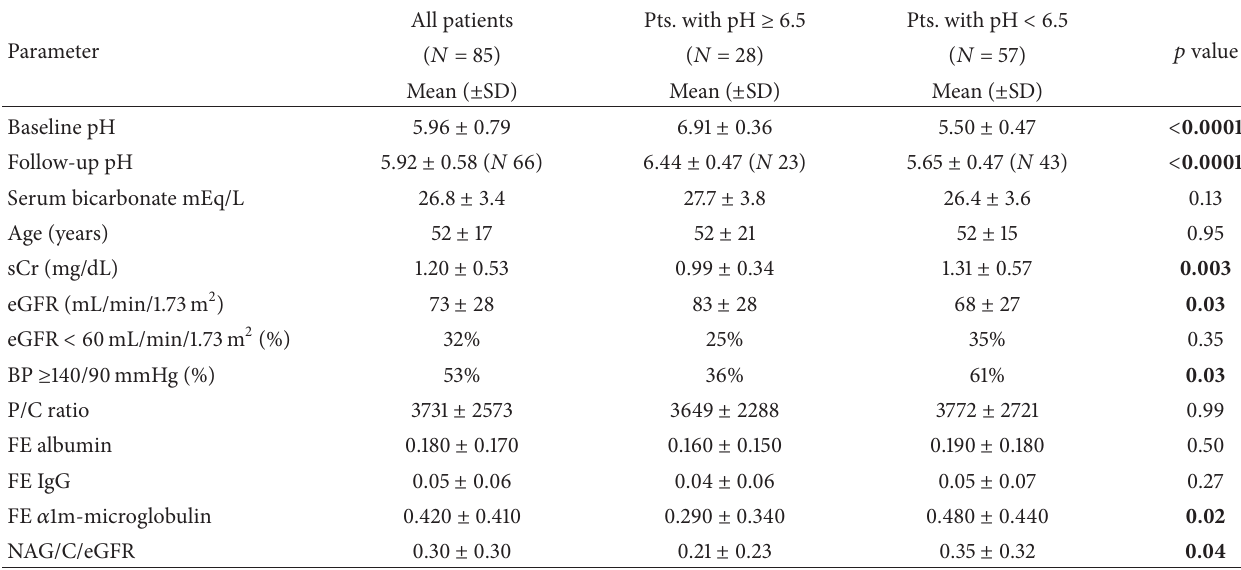
Table 1: Comparison of baseline and follow-up urinary pH and clinical, functional, and proteinuric parameters in 85 IMN patients with pH ≥ 6.5 ( N 28) or pH < 6.5 ( N 57).